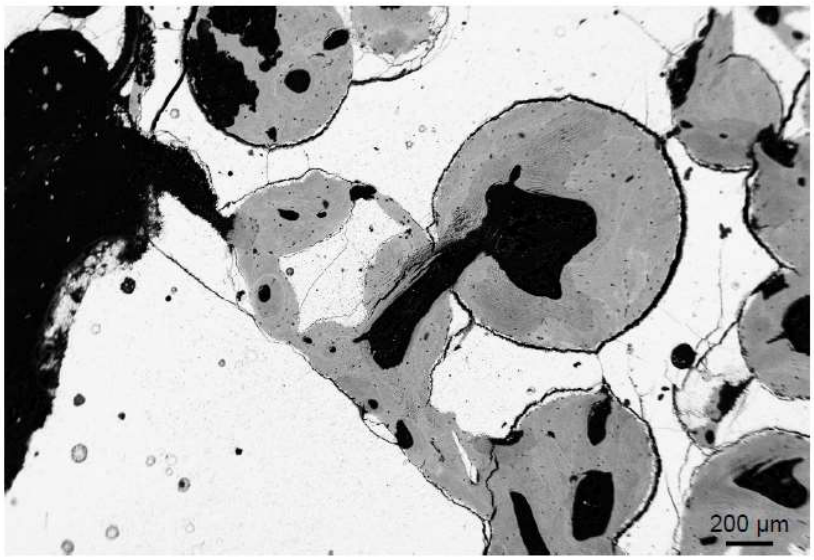
Figure 5. Bone ingrowth into a porous-coated tantalum implant (human). Image acquired by backscattered electron microscopy.